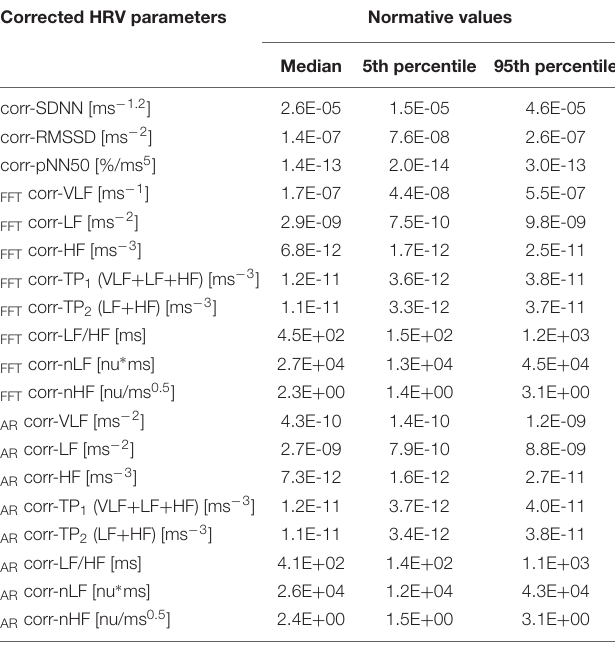
TABLE 5 | Normative values for corrected HRV parameters for the whole study group. Corrected HRV parameters Normative values Median 5th percentile 95th